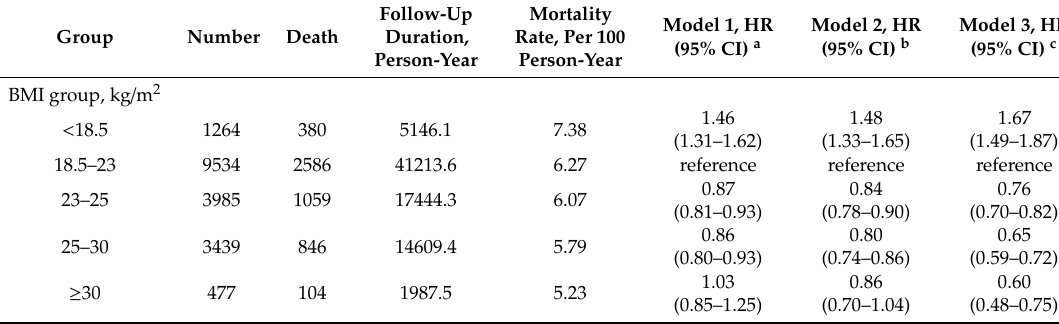
Figure 2. Kaplan–Meier estimation of the cumulative incidence probability of all-cause mortality. The analyses are stratified by ( A ) 5 baseline BMI categories and ( B ) 6 baseline WC categories. BMI, body mass index; WC, waist circumference. Table 2. Mortality rates and hazard ratios of all-cause mortality by BMI or WC.